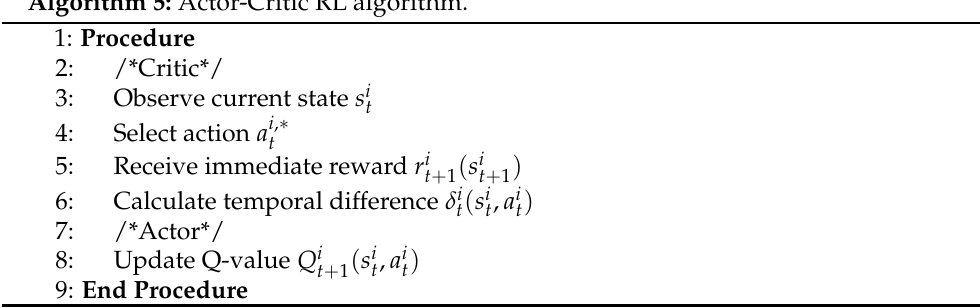
Algorithm 5: Actor-Critic RL